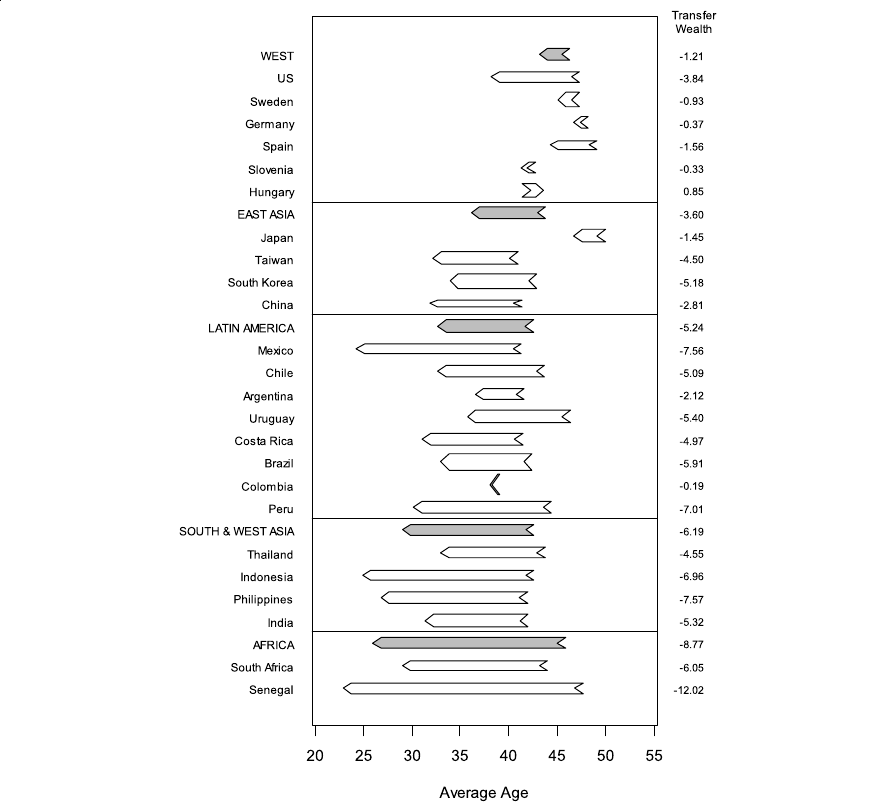
Fig. 7 Direction of total transfer flows (public + private). Note: Head of arrows is average age of receiving public plus private transfers, and tail is average age of paying tax or making private transfer. Countries ranked within region by per capita GDP (ppp-adjusted, US$) in 2005. Regional averages are unweighted. Regions ranked by per capita GDP. Source: For National Transfer Accounts data, see ntaccounts.org. Average age and per capita calculations use United Nations Population Division (2013) population data for year of NTA age